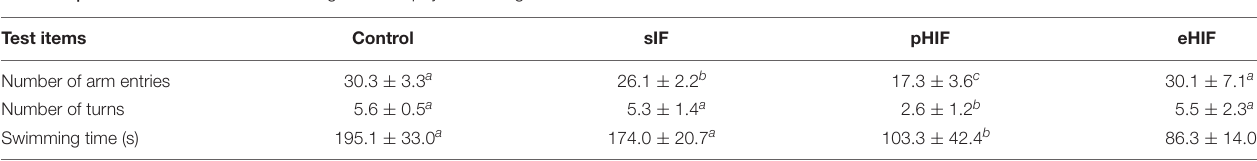
TABLE 2 | Effects of infant formula on intelligence and physical strength in